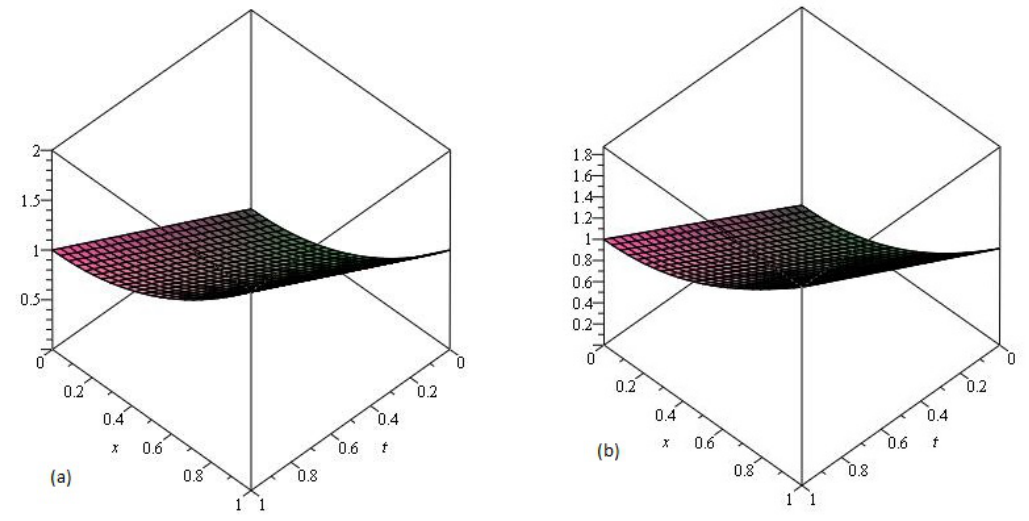
Figure 6. The ( a ) Exact and ( b ) LADM solutions of υ ( x , t ) of Example 4.3, at γ =